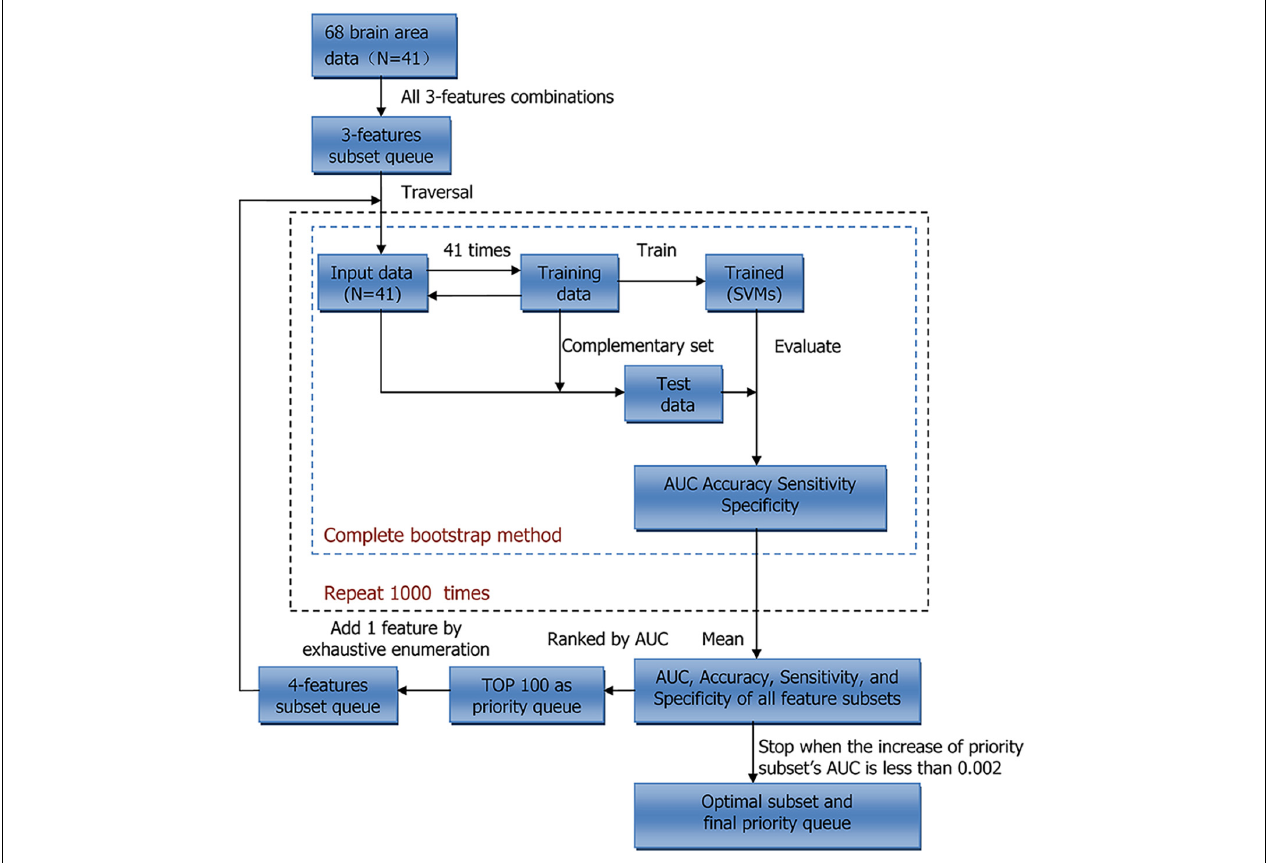
FIGURE 1 | Workflow of Beam search. N indicates sample size. AUC, area under curve; SVMs, support vector